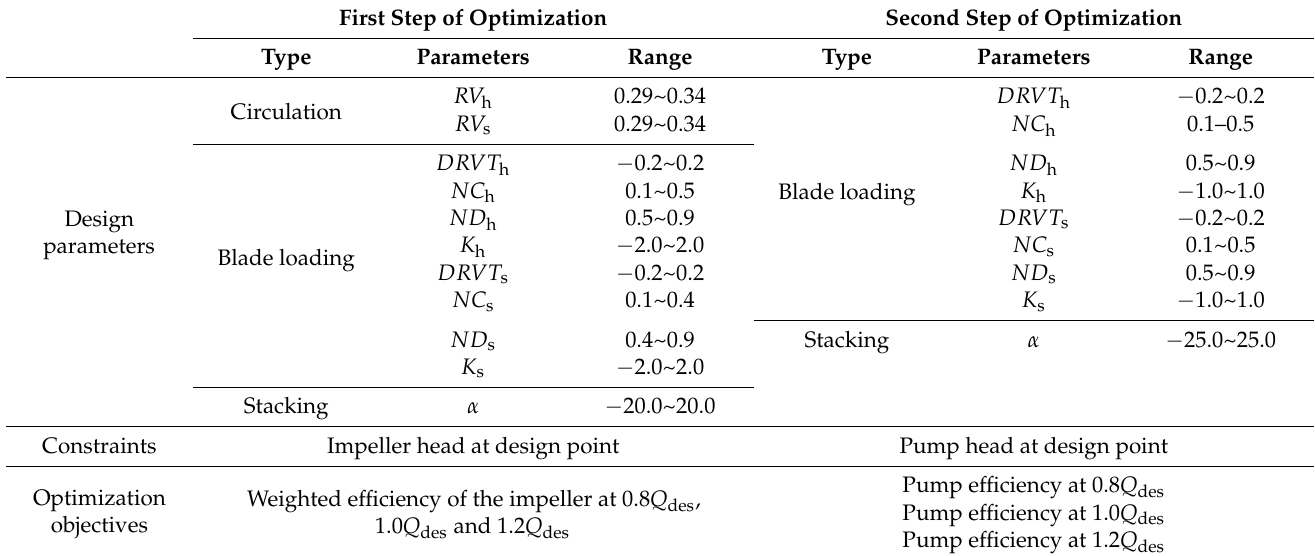
Table 2. Design parameters, constraints and optimization